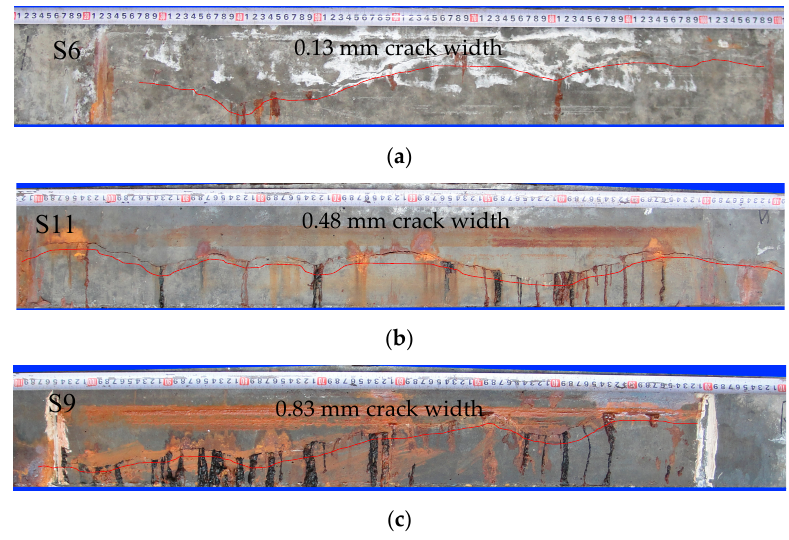
Figure 4. Longitudinal crack and corrosion products on concrete surface: ( a ) Slight cracking; ( b ) modest cracking; and ( c ) severe cracking